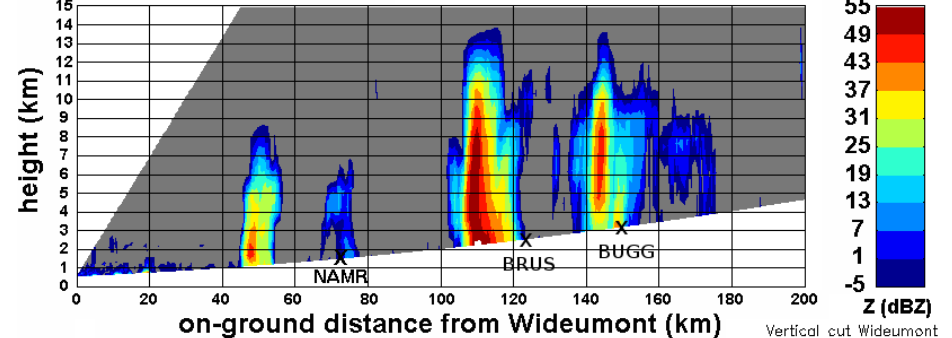
Figure 13. Radar imaging of a vertical cut of reflectivity (in dBZ up to 15km) from Wideumont radar to a distance of 200km in the north- west direction (12:05UTC, 29 June 2005). Projections of the BRUS and BUGG stations (respectively 6km and 13km distant) on this axis are plotted on this graph.